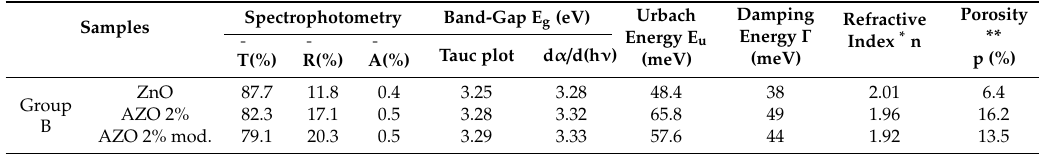
Table 5. A summary of observed values for the optical properties of Group B samples after the additional heat treatment.